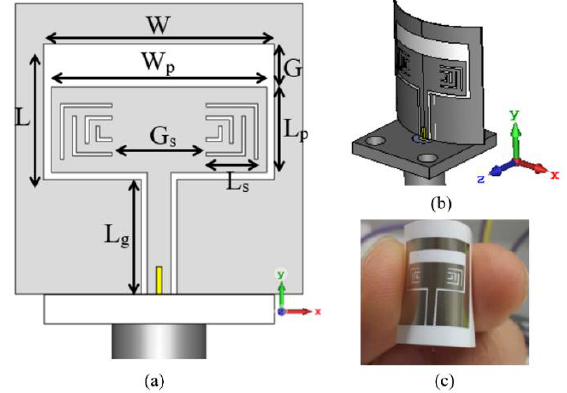
Figure 10. Patch antenna fabricated on PET film based on inkjet-printing technique: ( a ) simulated model; ( b ) simulated bended antenna; ( c ) fabricated prototype [81].